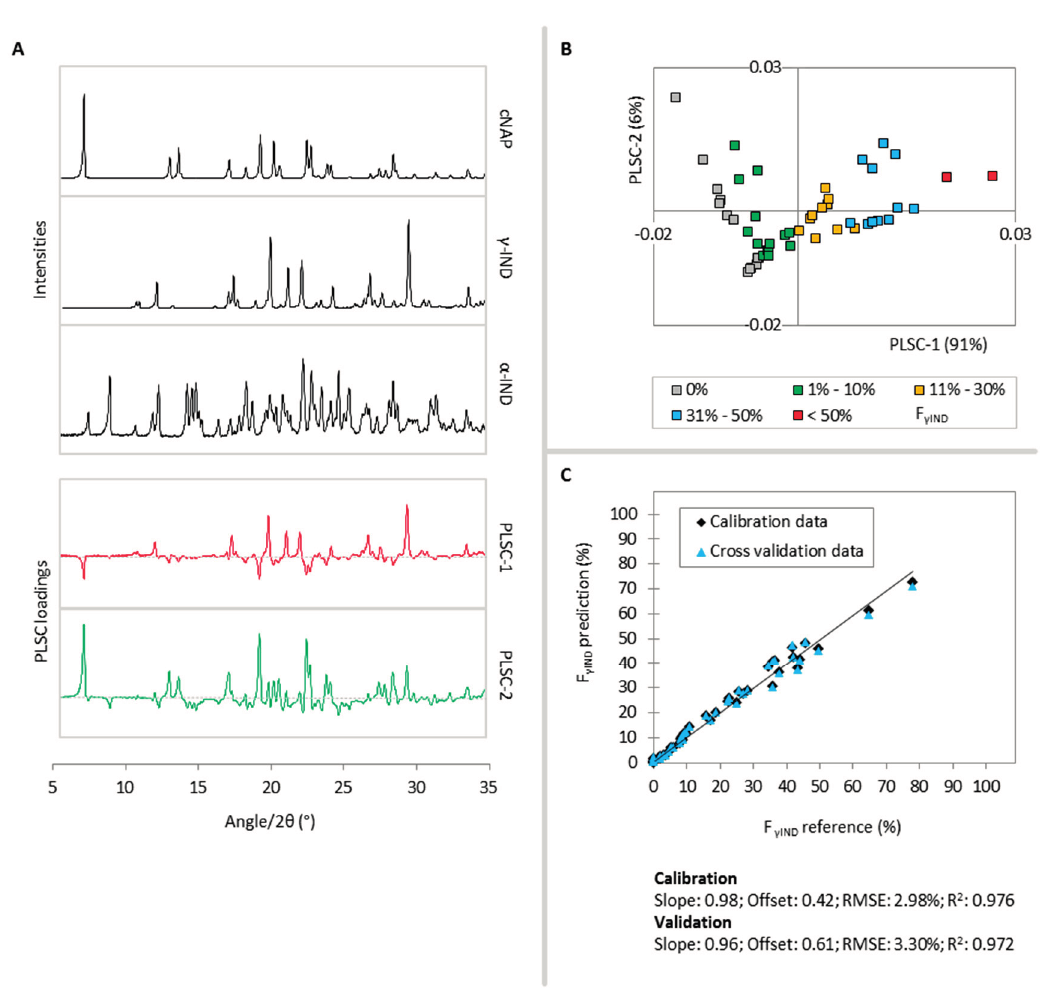
Figure 3. ( A ) Reference diffractograms of cNAP, γ -IND, α -IND (black lines) and PLSC-1 (red) and PLSC-2 (green) loadings plots for the F γ IND PLS model; ( B ) PLSC-1- vs. -PLSC-2 scores plot, the different colors classify the calibration samples according to their γ -IND fractions; ( C ) Correlation of the PLS predicted γ -IND fraction vs. the reference values during the calibration (black diamonds) and cross validation (blue